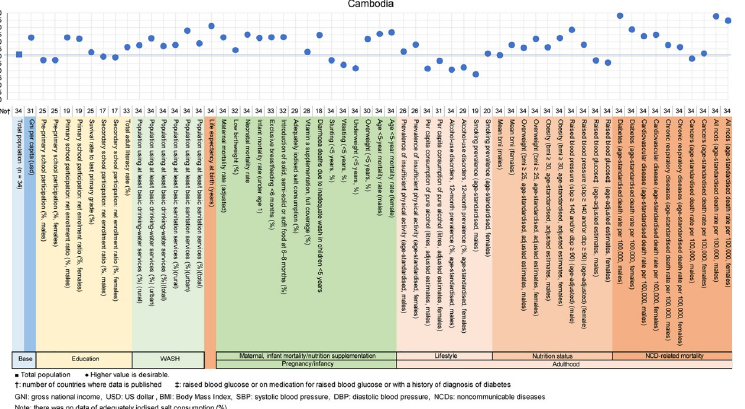
Fig 8. Country diagnosis by the deviation graph for